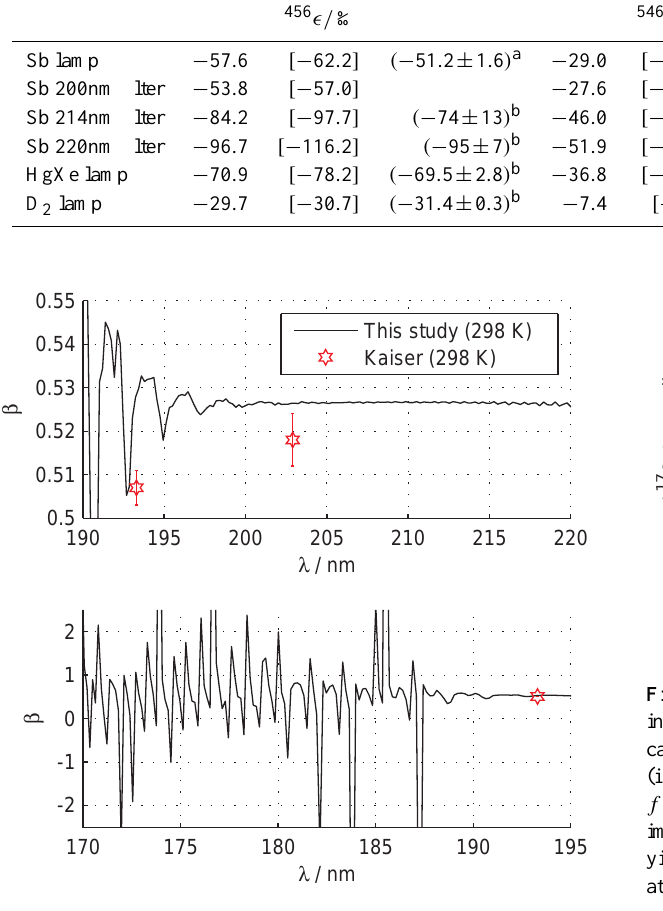
Fig. 5. The three-isotope exponent (see Eq. 10) at room temper- ature compared to ArF ( λ = 193 . 3nm) and Sb-lamp ( λ ∼ 202nm) experimental results of Kaiser et al. (2004)